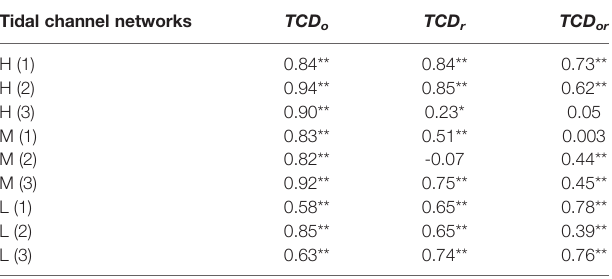
TABLE 5 | The Pearson correlations between proportion of S. alterni fl ora [see its de fi nition in Sun et al. (2020)] and normalized spatially-varying TCD indices.